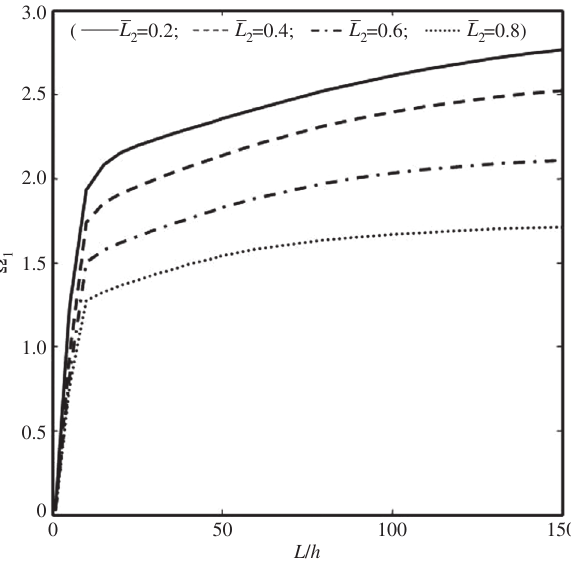
Figure 9 Effect of length-to-thickness ratio on dimensionless fun- damental natural frequencies of the delaminated LCB with various delamination lengths.